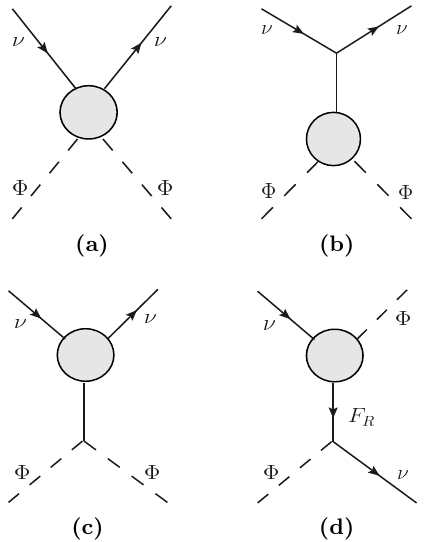
Figure 1. Topologies of e(cid:11)ective neutrino-DM interactions. Figure (a), (b), (c) and (d) represent topology I, II, III and IV